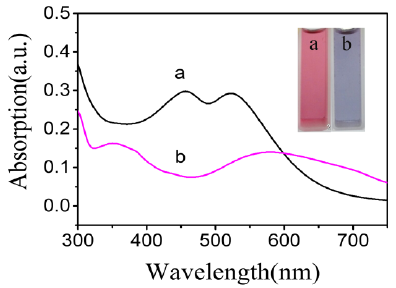
Figure 7. UV-Vis spectra of the NR-β-CD@AuNPs (a) and NO 2 -NR-β-CD@AuNPs (b).